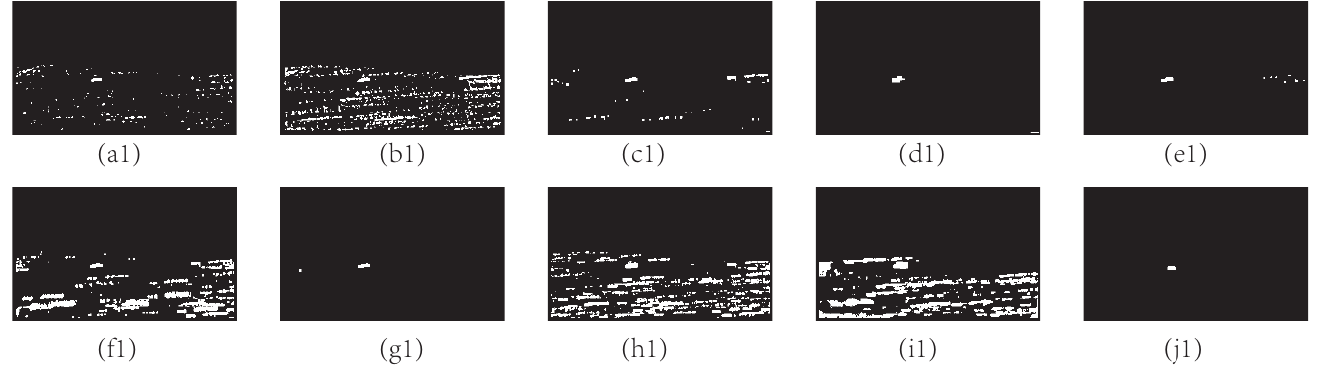
Figure 13. Panels ( a1 – j1 ) shows the detection results of sequence B of top hat, ANI, PSTNN, ASTTV, GST, NTFRA, NRAM, HB-MLCM, ADMD, and the proposed method.